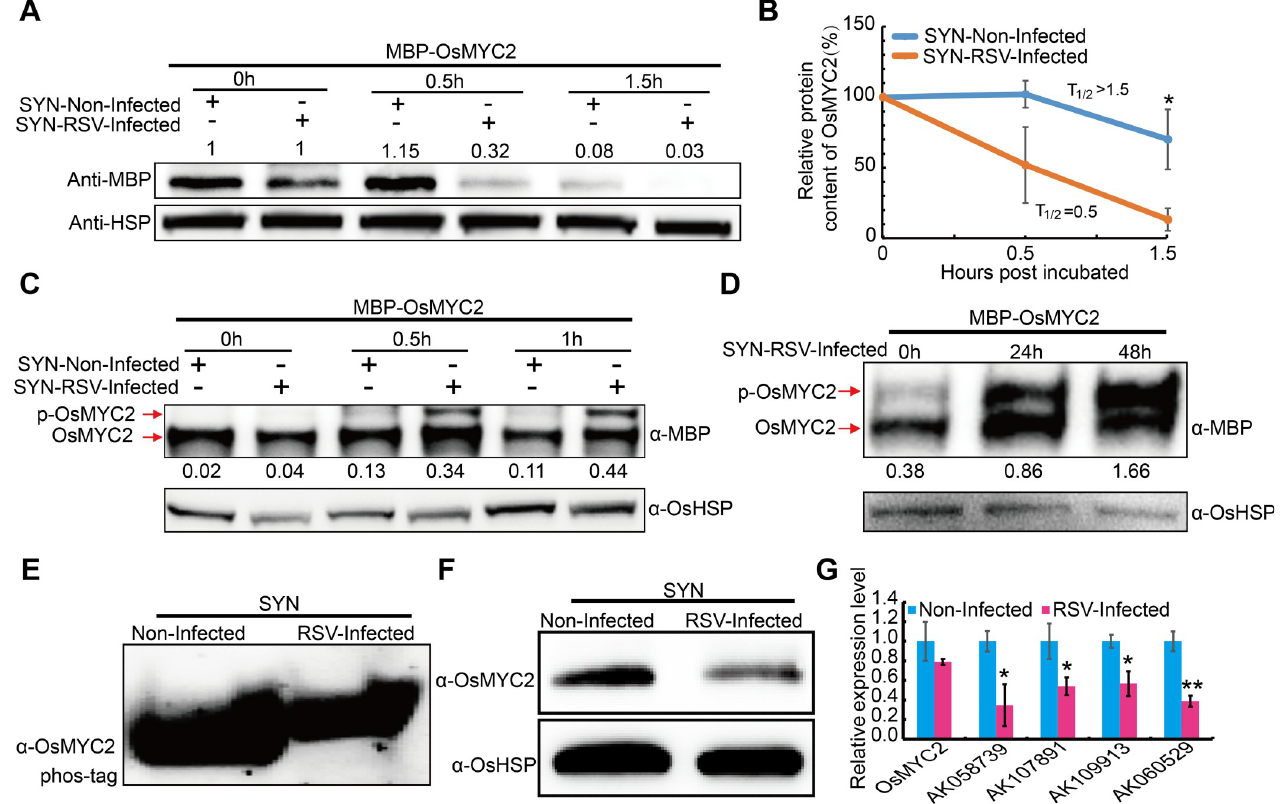
Fig 10. RSV infection induces the degradation of OsMYC2 by phosphorylation. (A) OsMYC2 protein levels in the RSV-infected and non-infected SYN rice plants. OsHSP indicates loading control. The number on the panel indicate the protein level of MBP-OsMYC2 relative to its initial value (0 h). The experiment was repeated four times. (B) Half-life plot for cell-free degradation of MBP-OsMYC2 in (A). (C) Phosphorylation levels of MBP-OsMYC2 incubated with the extracts from RSV-infected and non-infected rice plants using Phos-tag gels. The number under the panel indicate the ratio of pOsMYC2 versus OsMYC2. The experiment was repeated two times. (D) Determination of protein phosphorylation levels incubated with the extracts from rice plants collected at 0, 24 and 48 h post infection with RSV using Phos-tag gels. The number under the panel indicate the ratio of pOsMYC2 versus OsMYC2. The experiment was repeated three times. (E) Phosphorylation analysis of OsMYC2 in RSV-infected and non-infected plants using Phos-tag gels. The experiment was detected four independent RSV-infected and non-infected plants, respectively. (F) OsMYC2 protein levels in the RSV-infected and non-infected SYN rice plants. OsHSP indicates loading control. (G) The transcript levels of representative defense-related genes downstream of OsMYC2 in RSV-infected and non-infected SYN rice plants. AK058739 ( subtilisin/chymotrypsin inhibitor ), AK107891 ( lipid transfer protein ), AK109913 ( similar to thaumatin-like protein ) and AK060529 ( beta-1 , 3-glucanase ). Data are shown as mean ± SEM (n > 3). � P < 0.05, �� P < 0.01 by the Student’s t -test in B and